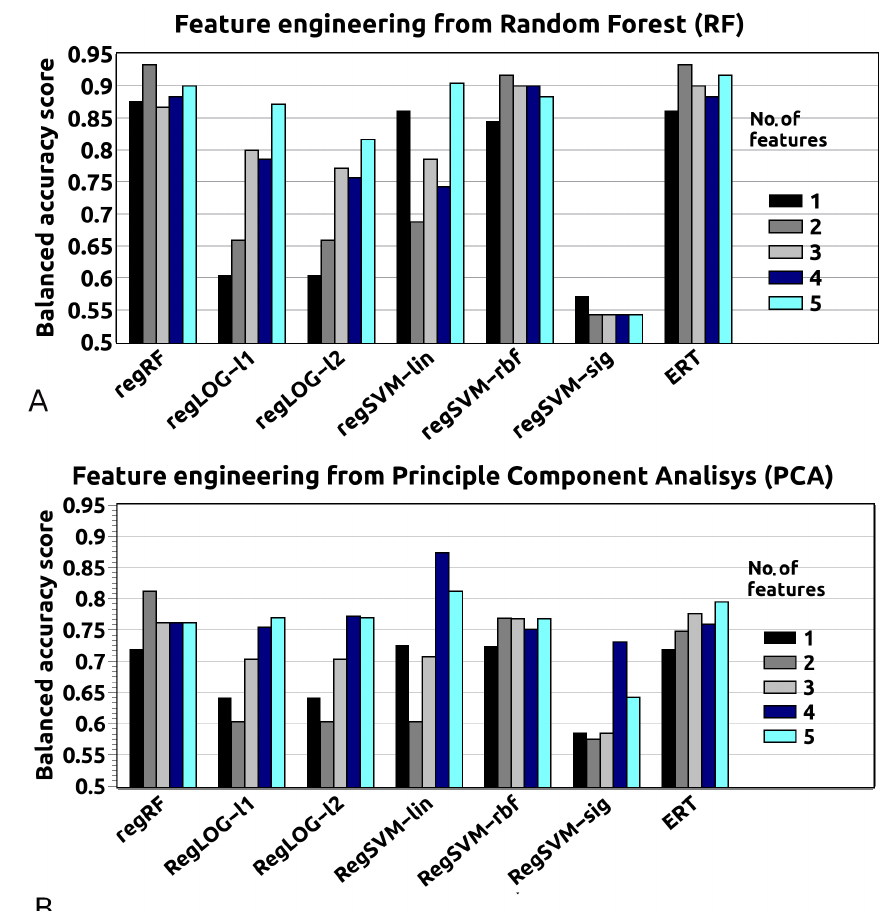
Figure 1. Feature engineering for dataset I obtained for two methods: ( A ) Random Forest (RF) and ( B ) Principle Component Analysis (PCA). Both methods are methodological tools that allow simplification of the